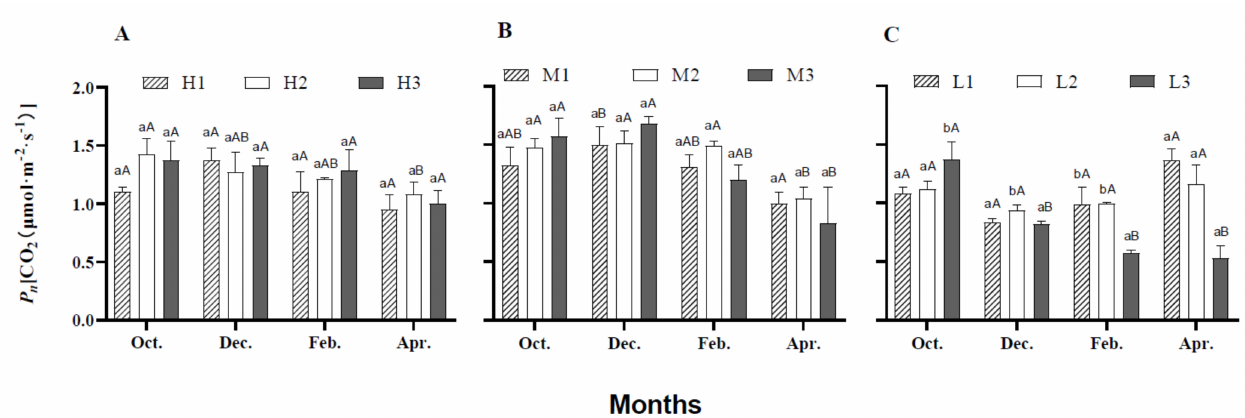
Figure 1. Net photosynthetic rate [CO 2 ( µ mol · m − 2 · s − 1 )] of Anthurium × ‘Red’ in greenhouse conditions. Where H ( A ), M ( B ), and L ( C ) represent PPFDs at 550, 350, and 255 µ mol · m − 2 · s − 1 , respectively. Data are presented as means, and vertical lines at each bar are the standard errors. Different lowercase letters indicate significant differences among different leaf positions in the same month, while uppercase letters indicate significant differences among various months at the same position based on Tukey HSD (honestly significant difference) test at P < 0.05 level. Numeric values 1, 2, and 3 represent the bottom old leaf, center mature leaf, and the top young expanded leaf,